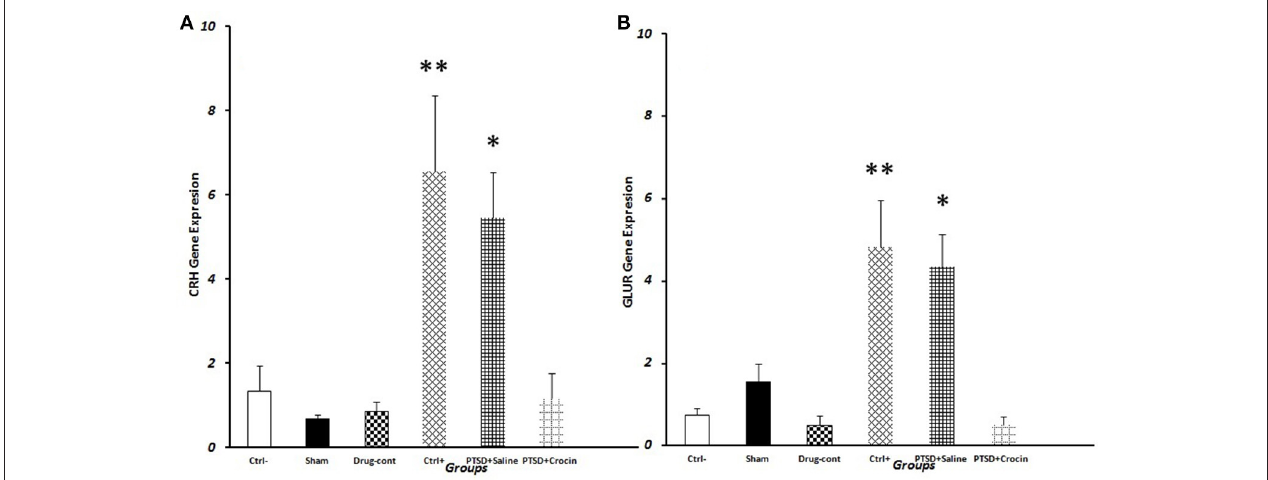
FIGURE 5 | Data are shown as mean ± SEM, n = 4 per groups. RT-PCR measurement of gene expression on the day 28 post-shock. (A) Hypothalamic CRH expression post-shock; * P < 0.05, ** P < 0.01 compared to the negative control group. (B) Pituitary GluR expression post-shock; * P < 0.05, ** P < 0.01 compared to the negative control